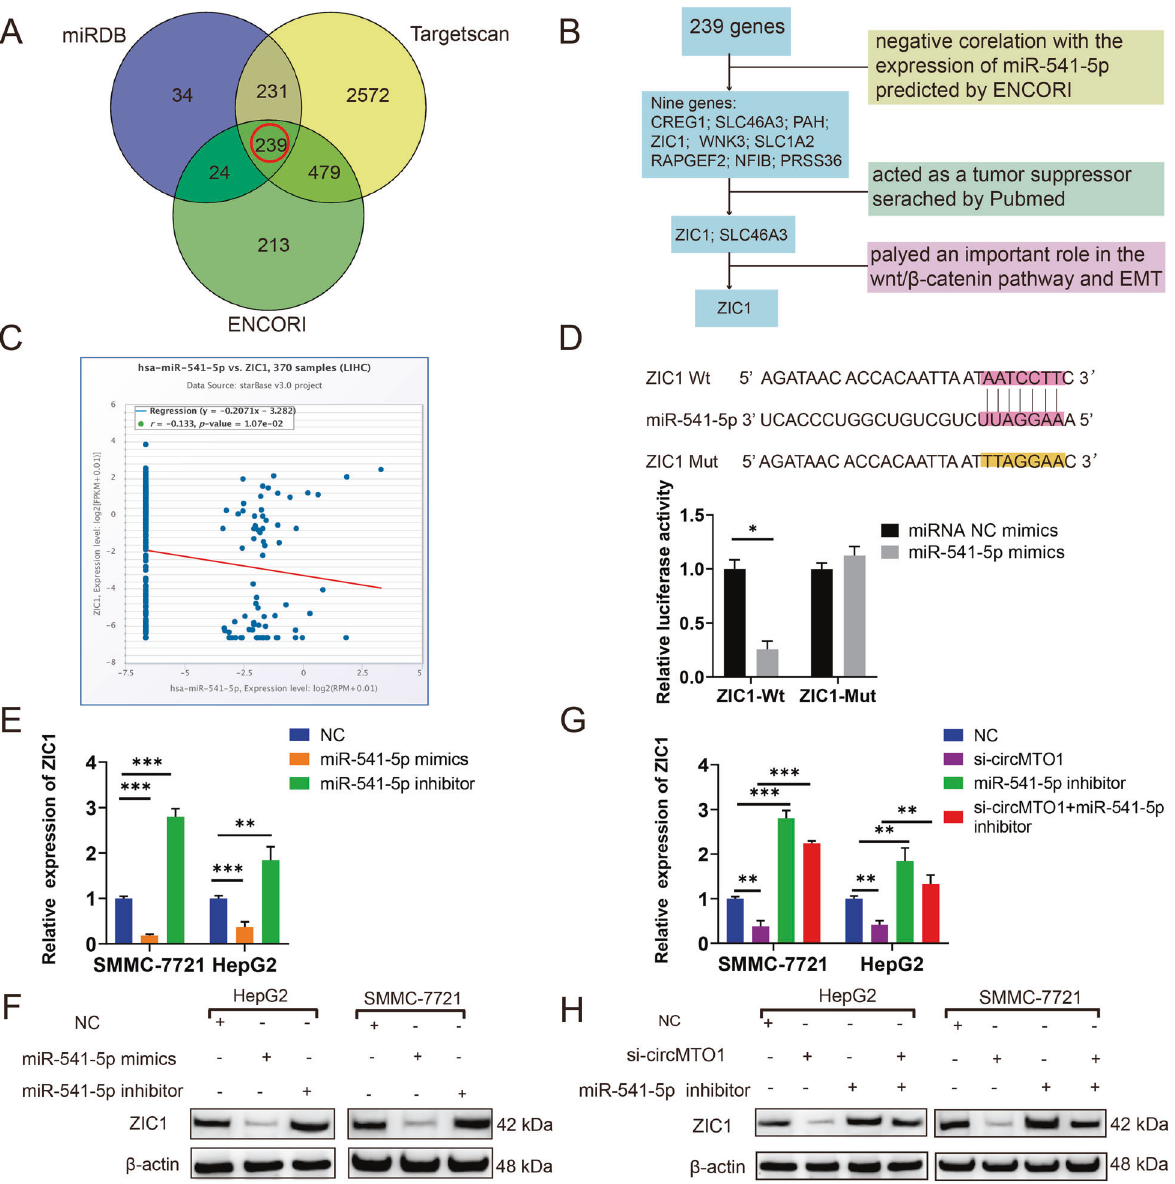
Fig. 5 ZIC1 was directly targeted by miR-541-5p. A , miRDB, TargetScan, and ENCORI databases were used to predict potential mRNA targets of miR-541-5p. B The screening process of miR-541-5p target candidate. C The co-expression of miR-541-5p and ZIC1 as predicted by ENCORI in HCC. D Schematic illustration of ZIC1 3 ′ UTR-Wt and 3 ′ UTR-Mut luciferase reporter vectors. E , F Relative ZIC1 mRNA and protein levels were detected in cells using RT-qPCR and western blot, respectively, after transfection with miR-NC, miR-541-5p mimics, and miR-541-5p inhibitor. G , H Relative ZIC1 mRNA and protein levels were detected in cells using RT-qPCR and western blot, respectively, after transfection with NC, si- circMTO1, miR-541-5p inhibitor, and si-circMTO1 + miR-541-5p inhibitor. Data were presented as mean ± SD of three independent experiments, * P < 0.05, ** P < 0.01, *** P <